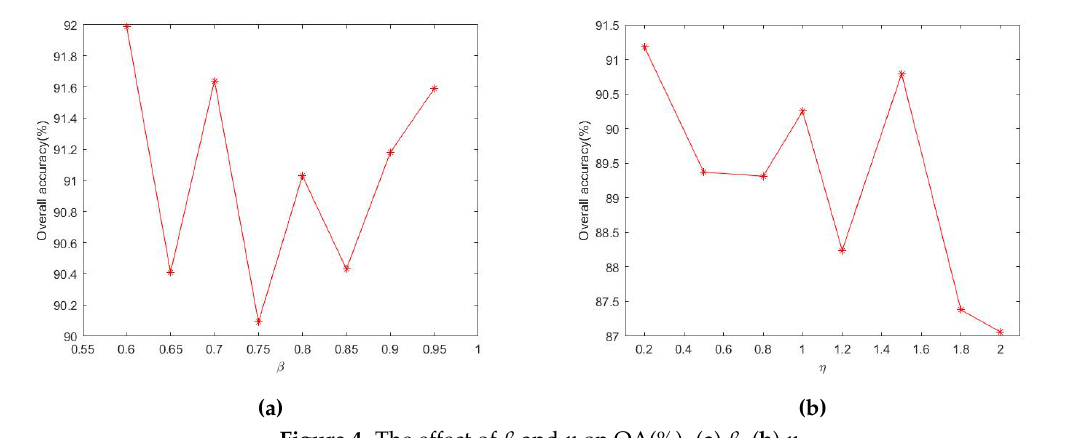
Figure 4. The effect of β and η on OA(%). ( a ) β , ( b ) η